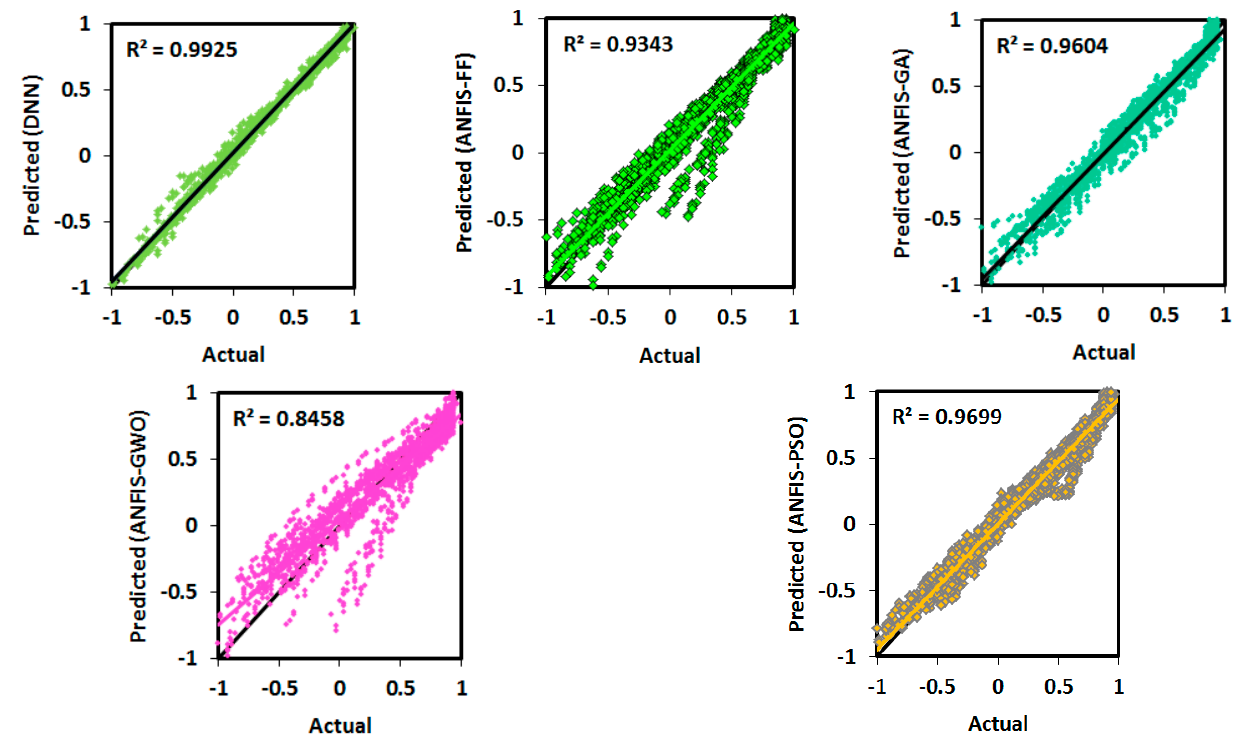
Figure 9. Illustration of actual and predicted strain in lateral ( x ) dimension (Testing phase).